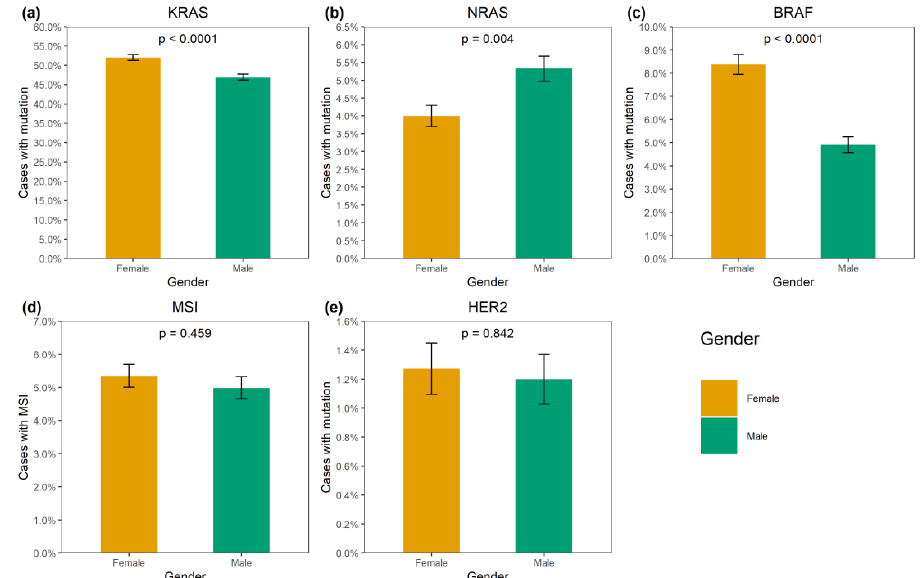
Figure 1. Association of genetic alterations with gender. ( a ) KRAS mutation, ( b ) NRAS mutation, ( c ) BRAF mutation, ( d ) MSI, ( e ) HER2 amplification.